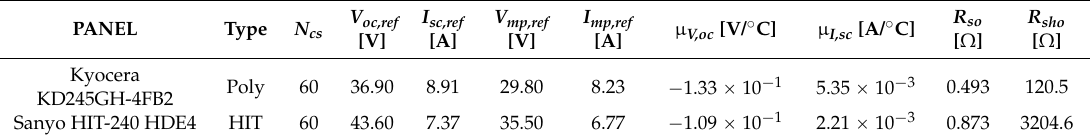
Table 2. Performance data of the simulated PV